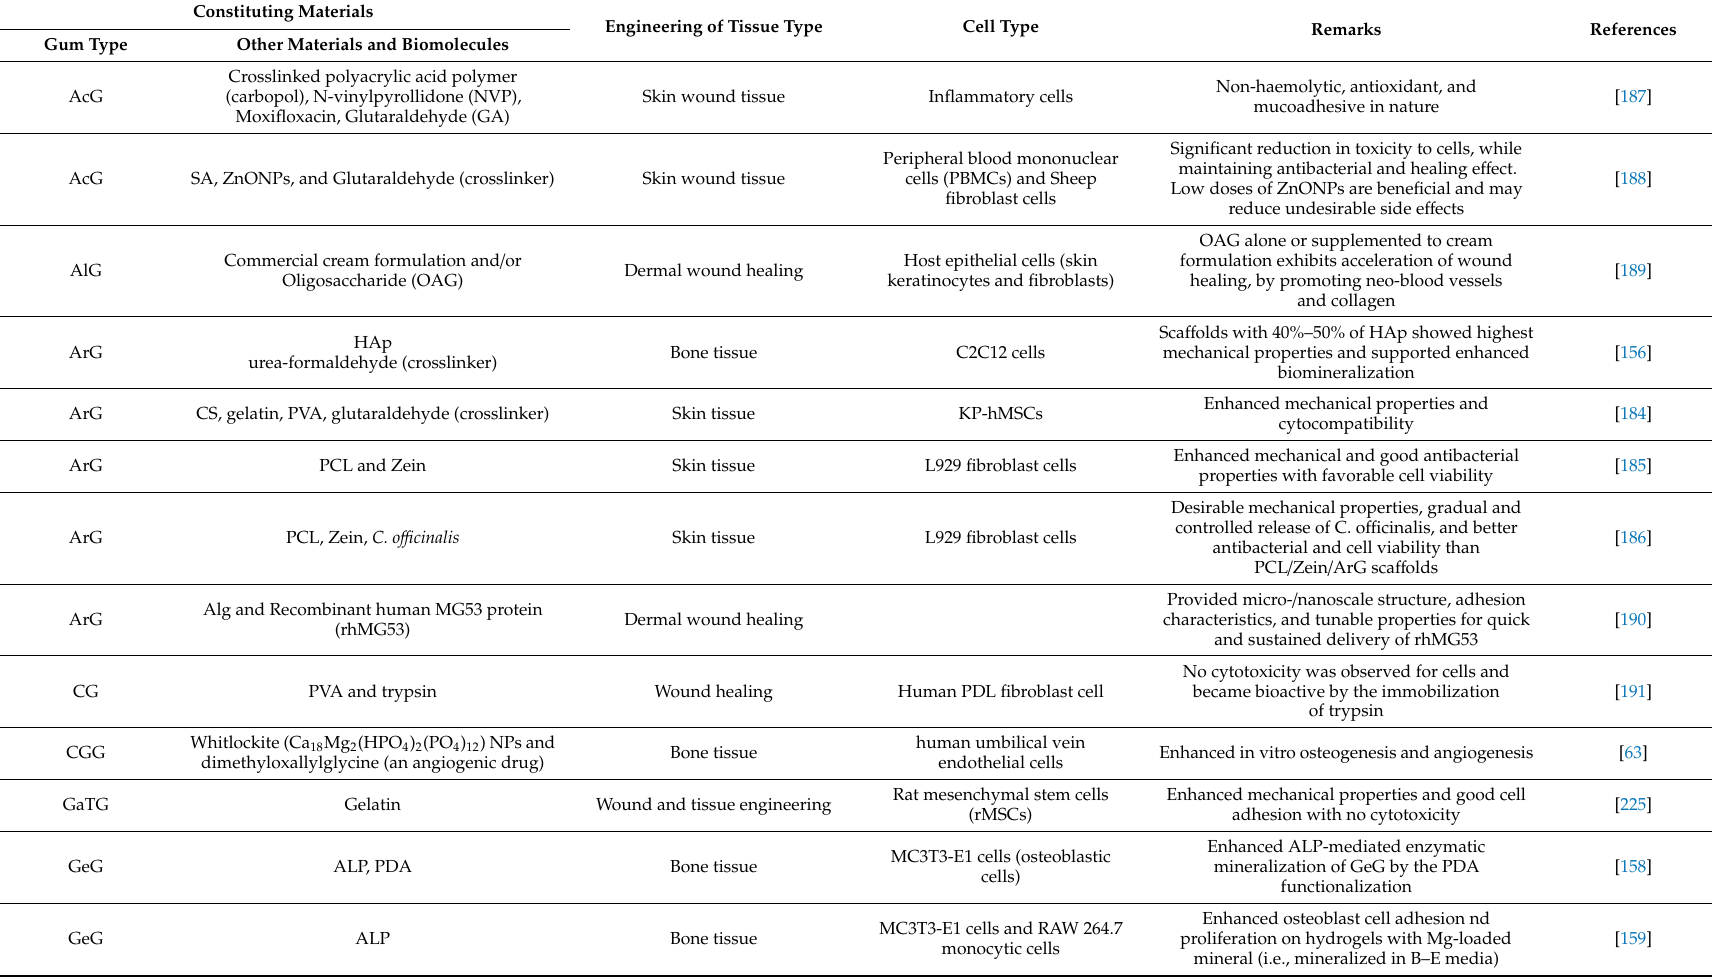
Table 2. Natural gum-based biomaterials for tissue engineering